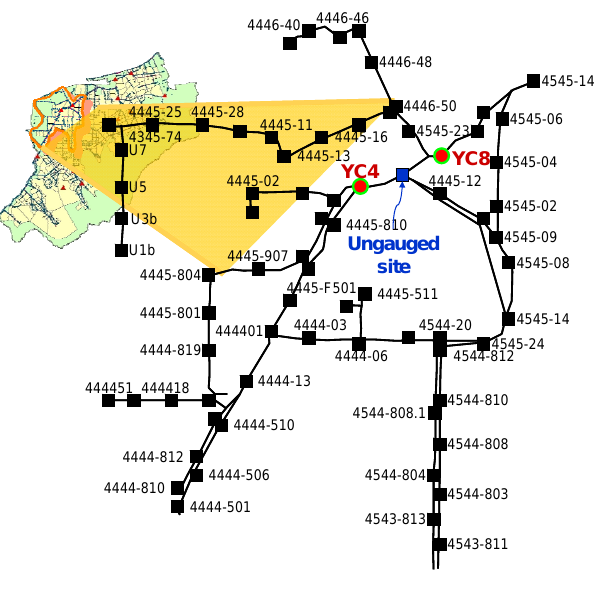
Figure 3 The location of the ungauged site 648 Fig. 3. The location of the ungauged site.